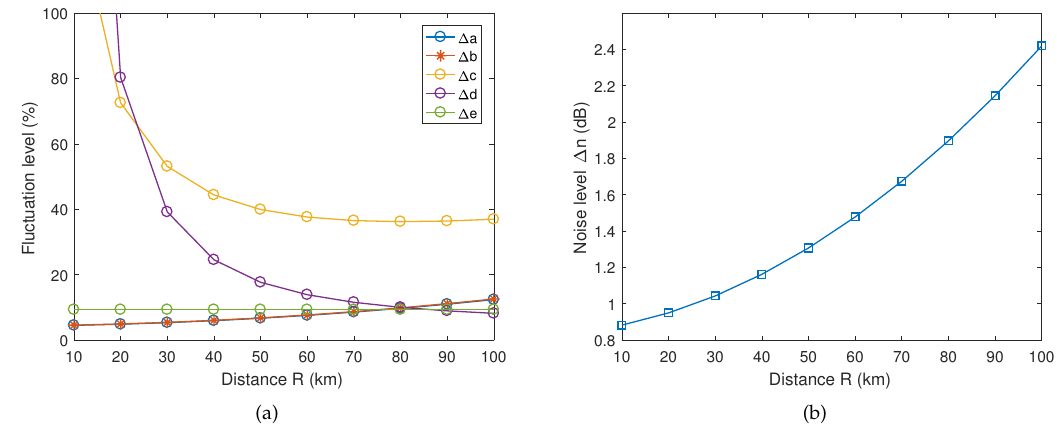
Figure 5. The limitations on ( a ) the error of the fitting coefficients and ( b ) the noise level on the power ratio, subject to the root mean square error of estimated wave height being within h s · 10% + 0.5 m.